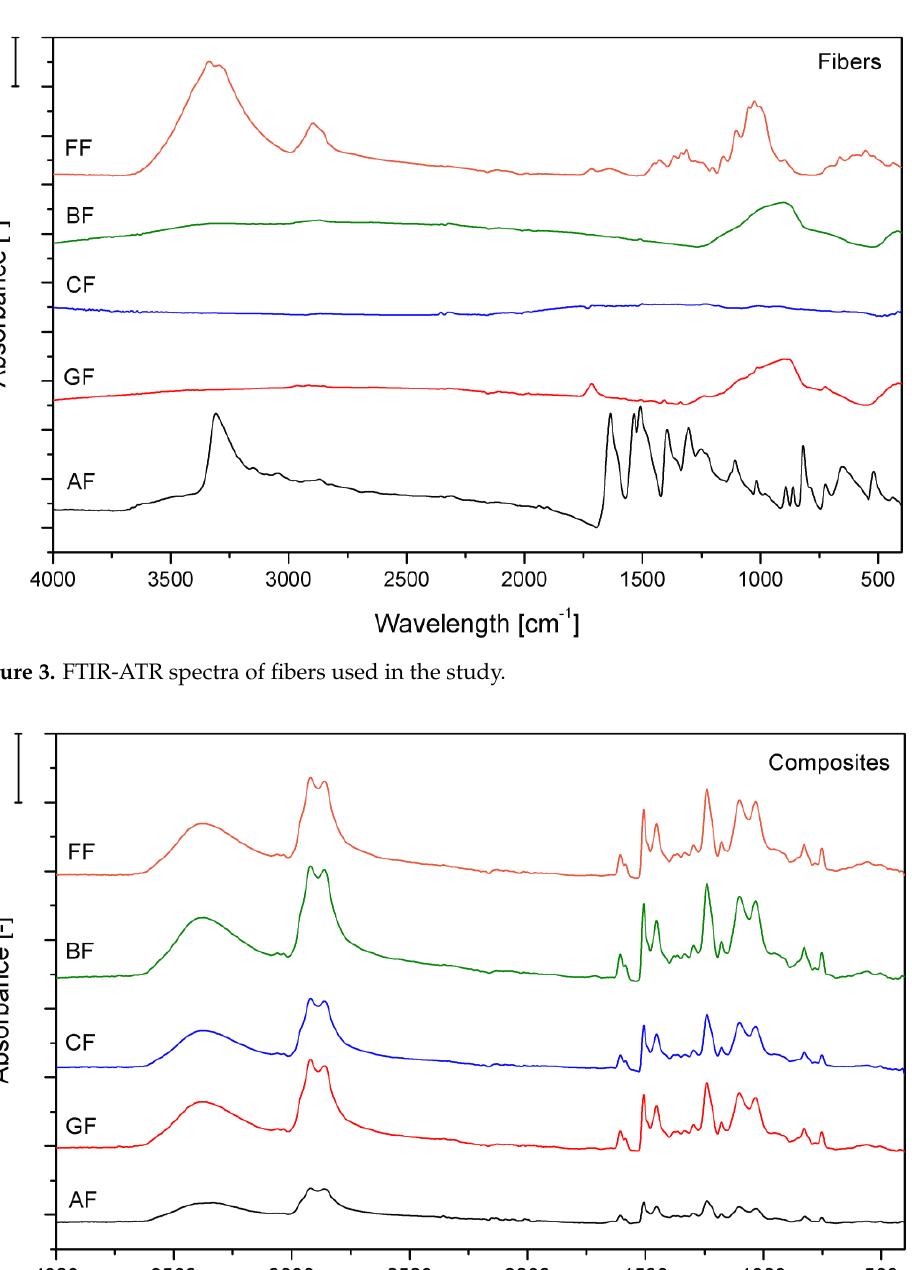
Figure 5. The density of composites and density of fabrics. According to the literature data, basalt fibers are mostly composed of silicon dioxide (49–51%), aluminum oxide (14–16%), iron oxides (7–13%), calcium oxide (10%), and mag- nesium oxide (6–16%), with minor shares of sodium, potassium, titanium, and manganese